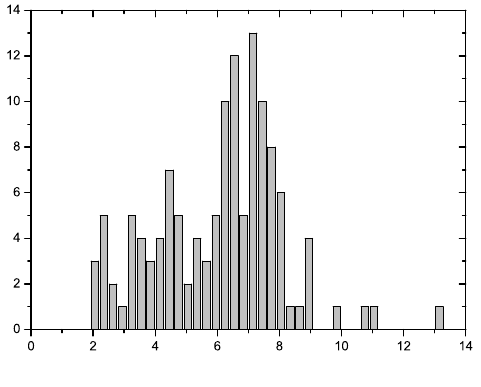
Figure 2: W 0 distribution of pre-core-collapse MW GCs.